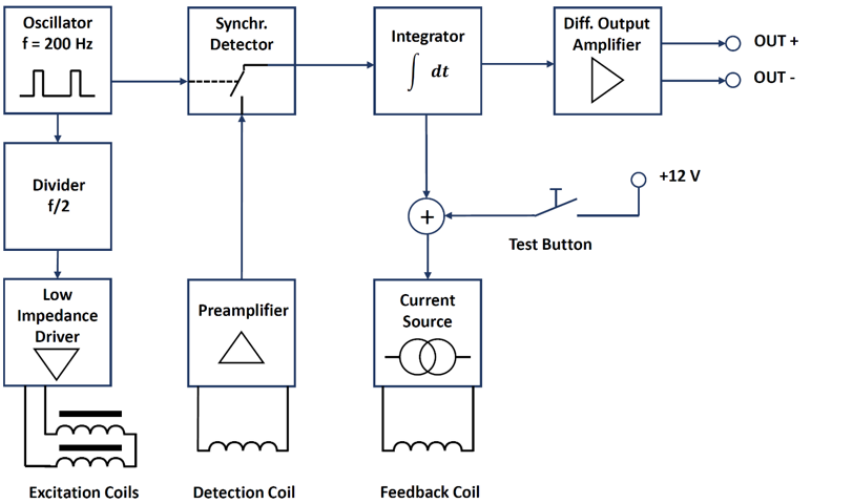
Figure 8. Conceptual scheme of the fluxgate magnetic sensor. The sensing part includes a feedback coil in order to achieve the required measurement